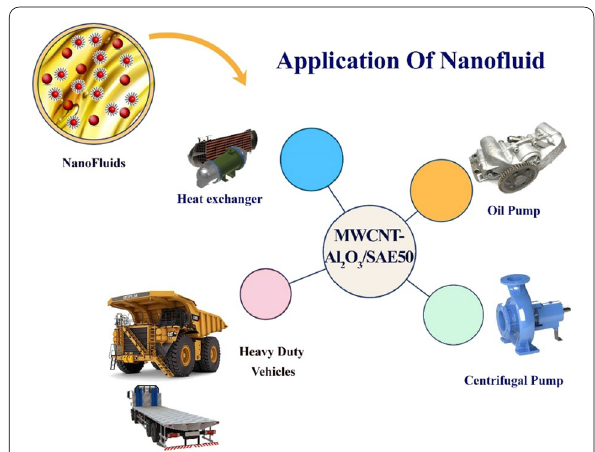
Fig. 1 Application of